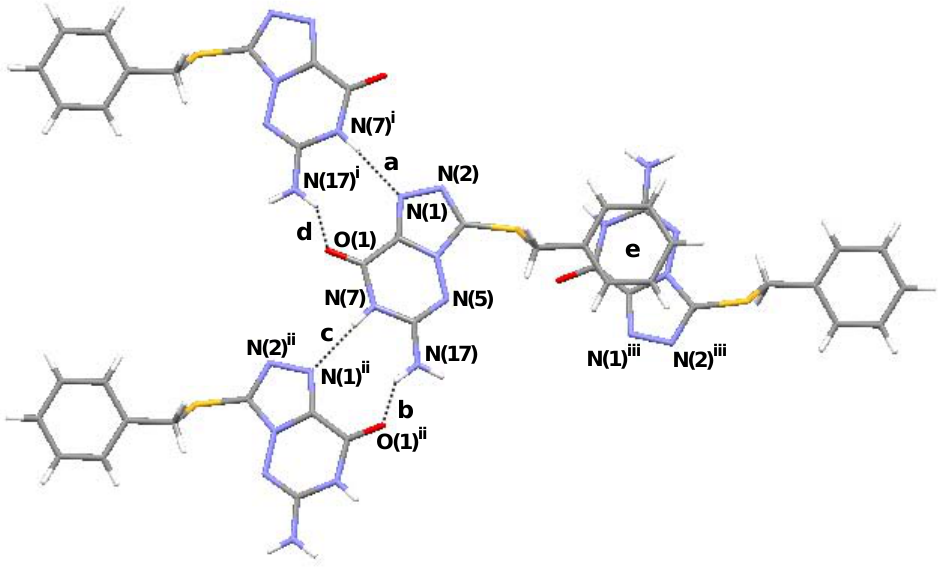
Figure 3. A part of the crystal structure of the title compound, showing the molecule stacking (notation [e]) direction along the a -view. Broken lines indicate the intermolecular hydrogen bonding patterns. For notation and symmetry codes see Table 1.